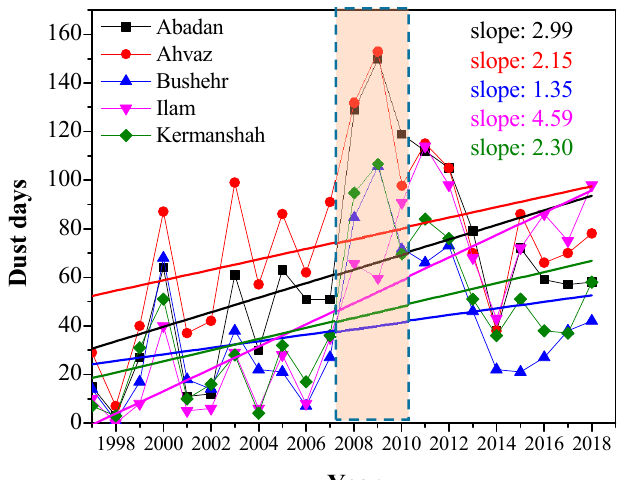
Figure 2. Annual variation of the number of dust days (lines+symbols) and associated trends (solid lines) at 5 stations in southwest Iran from 1997 to 2018. The highlighted column shows highest dust years.